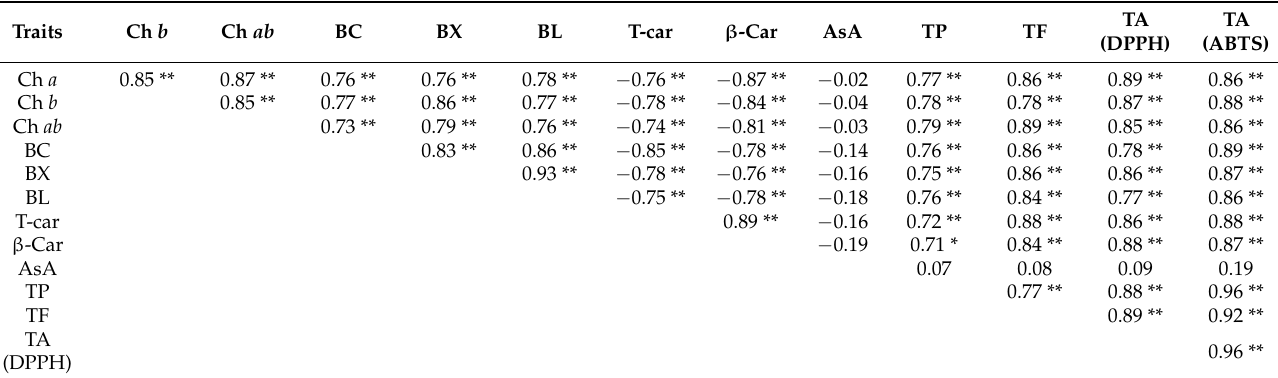
Table 5. The interrelationships for pigments, β -carotene, ascorbic acid, TP, TF, TA (DPPH and ABTS) in 12 selected slim amaranth